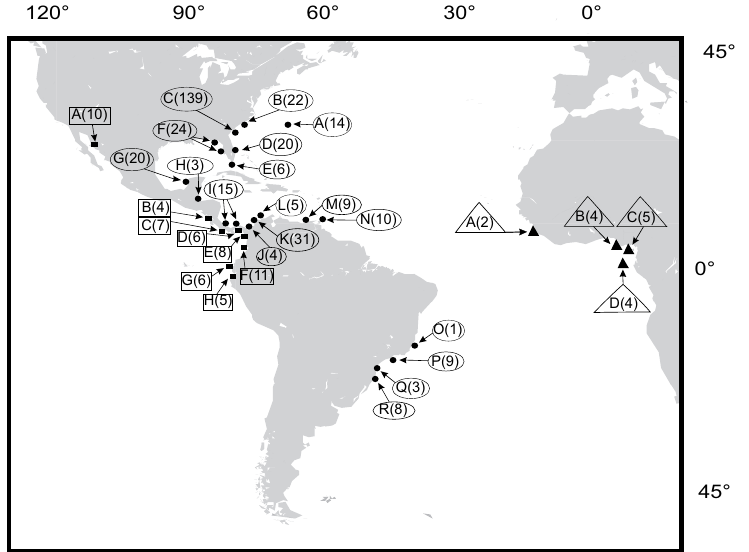
Figure 6. Collection localities of Petrolisthes armatus . Symbols and framed letters represent localities in each of the three oceans. Numbers in parentheses indicate sample size. WEST ATLANTIC: A: Bermuda; B: South Carolina: Conch Creek and Charleston; C: Georgia: Sapelo Island; D: Eastern coast of Florida: Fort Pierce; E: Florida Keys: Big Pine Key; F: Western coast of Florida: Tampa Bay and Dog Island; G: Yucatán Peninsula: Campeche; H: Belize: Tobacco Cay; I: Panamá: Bocas del Toro and entrance of the Panamá Canal; J: Colombia: Gulf of Urabá, Napú; K: Islas del Rosario and Gulf of Morrosquillo; L: Santa Marta; M: Venezuela: Isla Margarita; N: Trinidad; O: Brazil: Espírito Santo, Anchieta; P: São Paulo, São Sebastiao; Q: Paraná, Cabaraguara; R: Santa Catarina, São Francisco. EAST ATLANTIC: A: Sierra Leone: Freetown; B: Nigeria: Dowes Island; C: Cameroon: Limbe; D: São Tomé e Príncipe: Bom Bom Island. EAST PACIFIC: A: México: Sea of Cortez, Bahía Kino; B: Costa Rica: Bahía Salinas; C: Panamá: Chiriquí, Playa Hermosa; D: Ciudad de Panamá, Naos Island; E: Colombia: Chocó: Bahía Utría and Arusí; F: Valle del Cauca, Buenaventura and Bahía Málaga; G: Ecuador: Salinas; H: Isla Puná. Figure generated using the Map-It tool of the U.S. Geological Survey